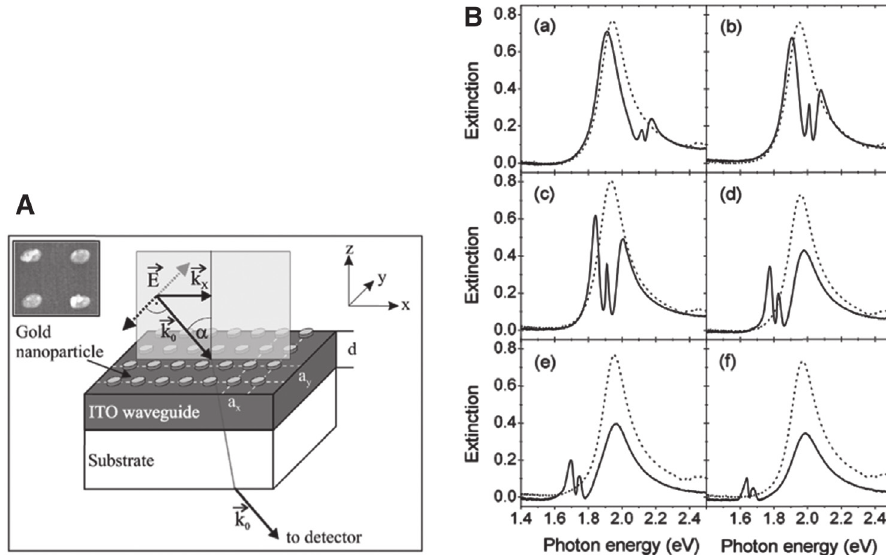
Figure 11: (A) Sketch of sample geometry. Inset: SEM picture of a gold nanoparticle array on a 140-nm-thick ITO waveguide. (B) Extinction of gold nanoparticles on a 140-nm-thick ITO waveguide. Solid lines: arrays with a fixed periodicity of 300 nm along the y axis and increasing periodicity from 350 nm to 475 nm in steps of 25 nm (A)–(F) along the x axis. Dashed lines: reference arrays with a periodicity of 300 nm for both axes. Reprinted figure with permission from S. Linden, J. Kuhl, and H. Giessen, Phys. Rev. Lett, 86, 4688–4691, 2001. Copyright (2001) by the American Physical Society.